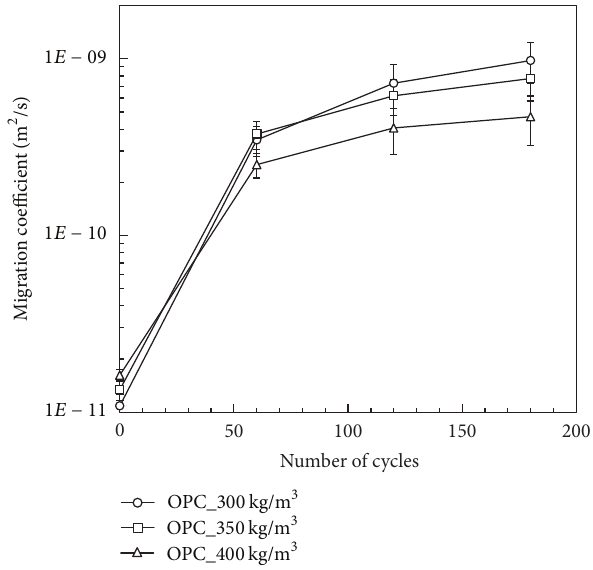
Figure 1: Migration coefficient for concrete after frosting depending on binder